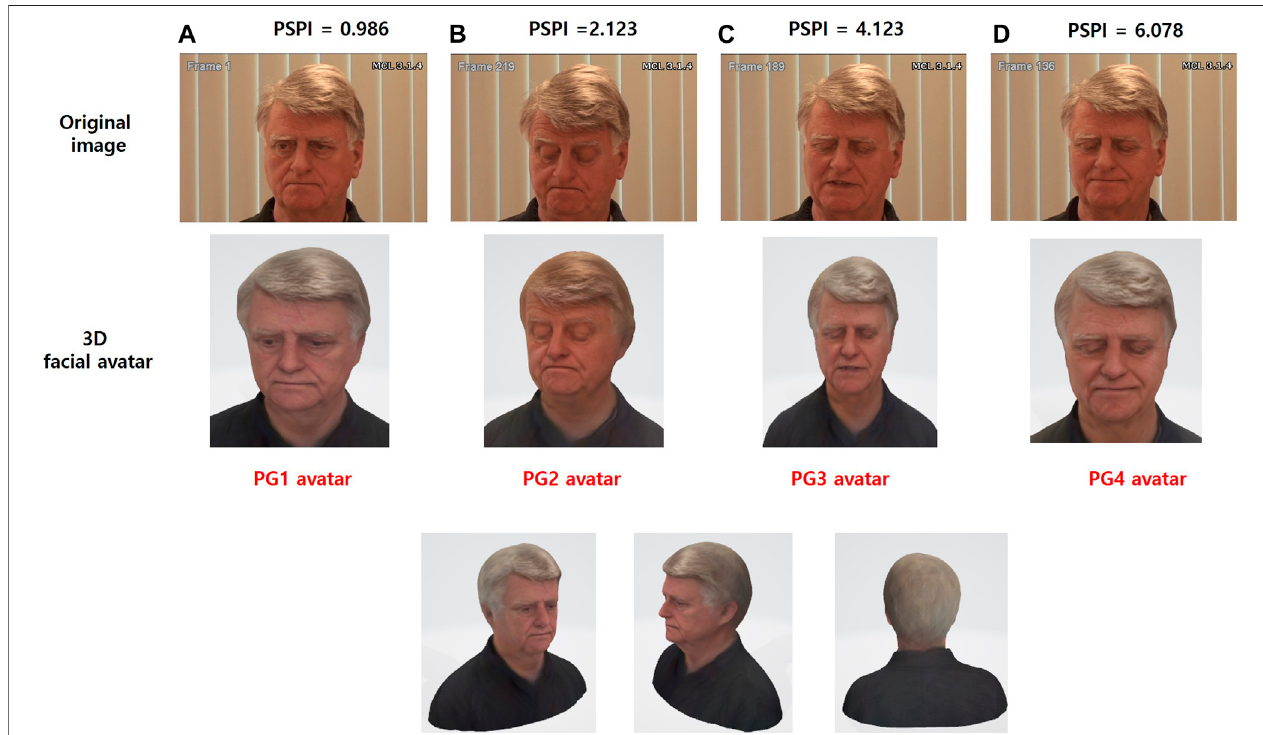
FIGURE5| Theprocedures ofgenerating3Dfacial avatarusing thePrkachinand Solomonpainintensity(PSPI) ofsubject#TV095fromtheUNBC-McMaster Pain Shoulder Archive. (A) The PG1 avatar was generated based on the PSPI of 0.986 from the original image (frame #1). (B) The PG2 avatar was generated based on the PSPI of 2.213 from the original image (frame #219). (C) The PG3 avatar was generated based on the PSPI of 4.123 from the original image (frame #189). (D) The PG4 avatar was generated based on the PSPI of 6.078 from the original image (frame #136).